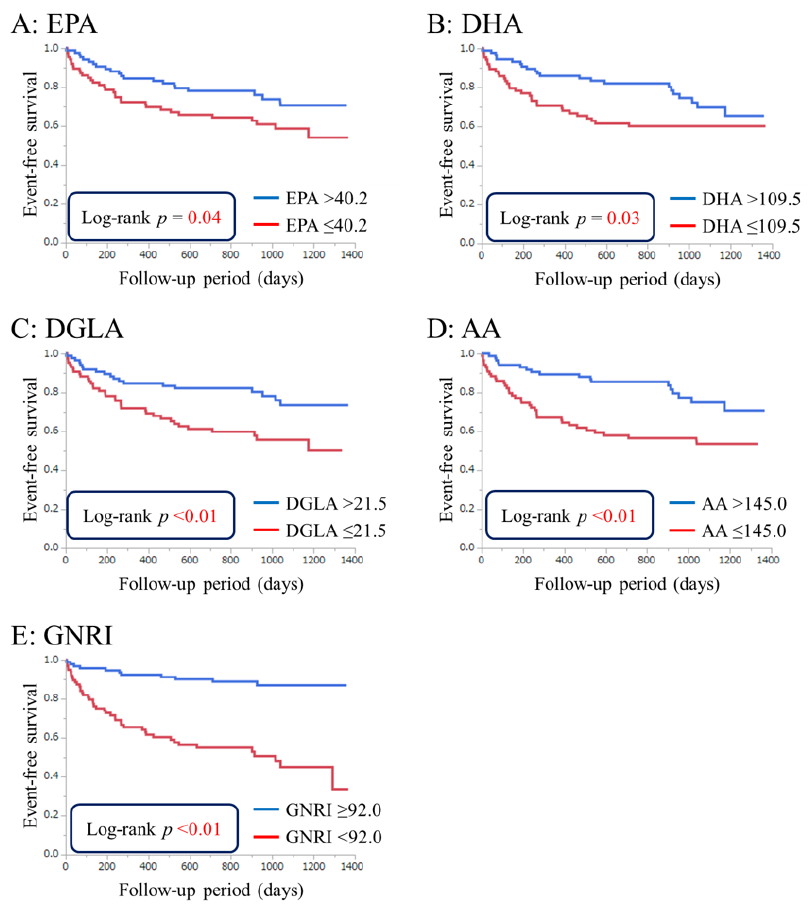
Figure 1. Event ‐ free survival curves for all ‐ cause death in patients with acute decompensated heart failure. Unadjusted cumulative event rates for the primary endpoint (all ‐ cause death) were estimated using the Kaplan ‐ Meier method and compared between the groups using the log ‐ rank test. Cutoff values were defined as the median polyunsaturated fatty acid levels. ( A ) eicosapentaenoic acid (EPA), 40.2 μ g/mL; ( B ) docosahexaenoic acid (DHA), 109.5 μ g/mL; ( C ) dihomo ‐ gamma ‐ linolenic acid (DGLA), 21.5 μ g/mL; ( D ) arachidonic acid (AA), 145.0 μ g/mL; ( E ) The patients were also divided into high ‐ GNRI (no or low risk; GNRI ≥ 92.0) and low ‐ GNRI (moderate or high risk; GNRI <92.0) groups.